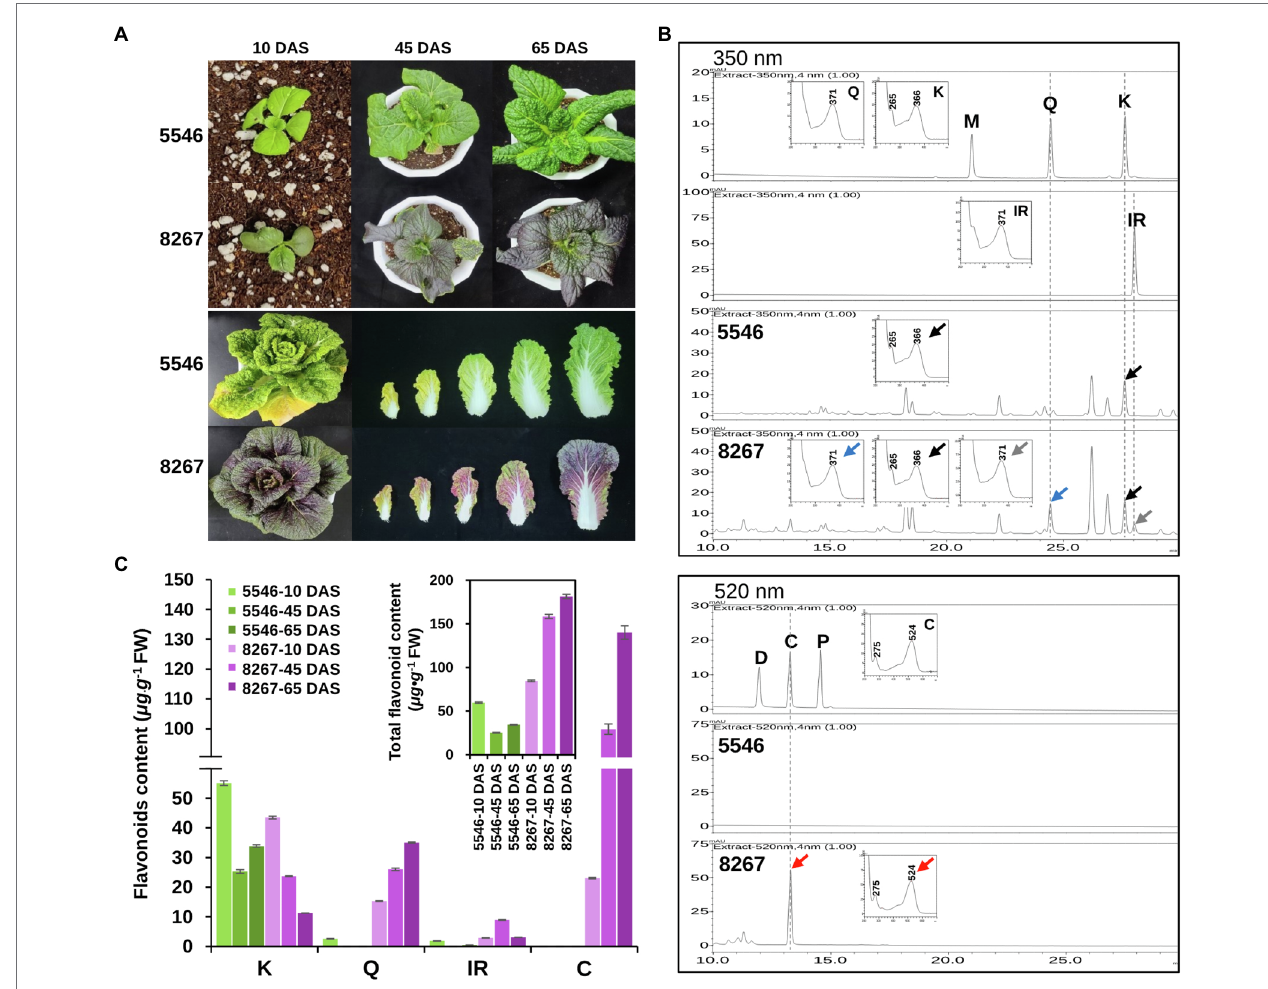
FIGURE 2 | Comparison of phenotypes and flavonoid content of the 5546 and 8267 varieties. (A) Leaf color changes of the 5546 and 8267 varieties during growth. DAS, days after sowing. (B) HPLC analysis of flavonoid aglycones and anthocyanidins in leaves of 45-day-old plants of the two varieties. Flavonoid aglycones were separated by HPLC and detected at 350 nm for flavonols (M, myricetin; Q, quercetin; K, kaempferol; IR, isorhamnetin) and 520 nm for anthocyanidins (D, delphinidin; C, cyanidin; P, pelargonidin). Peaks were identified by comparing relative retention times and UV spectra of reference substances. Black, grey, blue, and red arrows indicate peaks in samples and their UV spectrums corresponding to K, IR, Q, and C, respectively. (C) Average content of the major classes of flavonoid and total flavonoids content in leaves of the two varieties at different growth stages are displayed in (C) and the inset of (C) , respectively. Error bars indicate ± SD from three